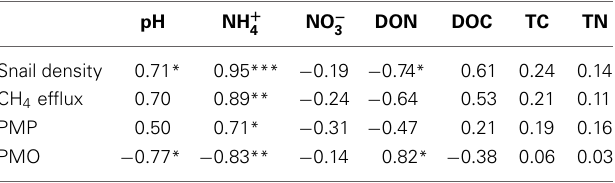
FIGURE 3 | CH 4 effluxes monitored in the microcosm headspace every 7 days of freshwater snail treatment and defaunated control (CK). Vertical bars denote standard errors of means ( n = 4). Table 1 | Coefficients of Pearson’s correlations between snail density, CH 4 efflux, microbial activities and sediment properties across all 8 sampling